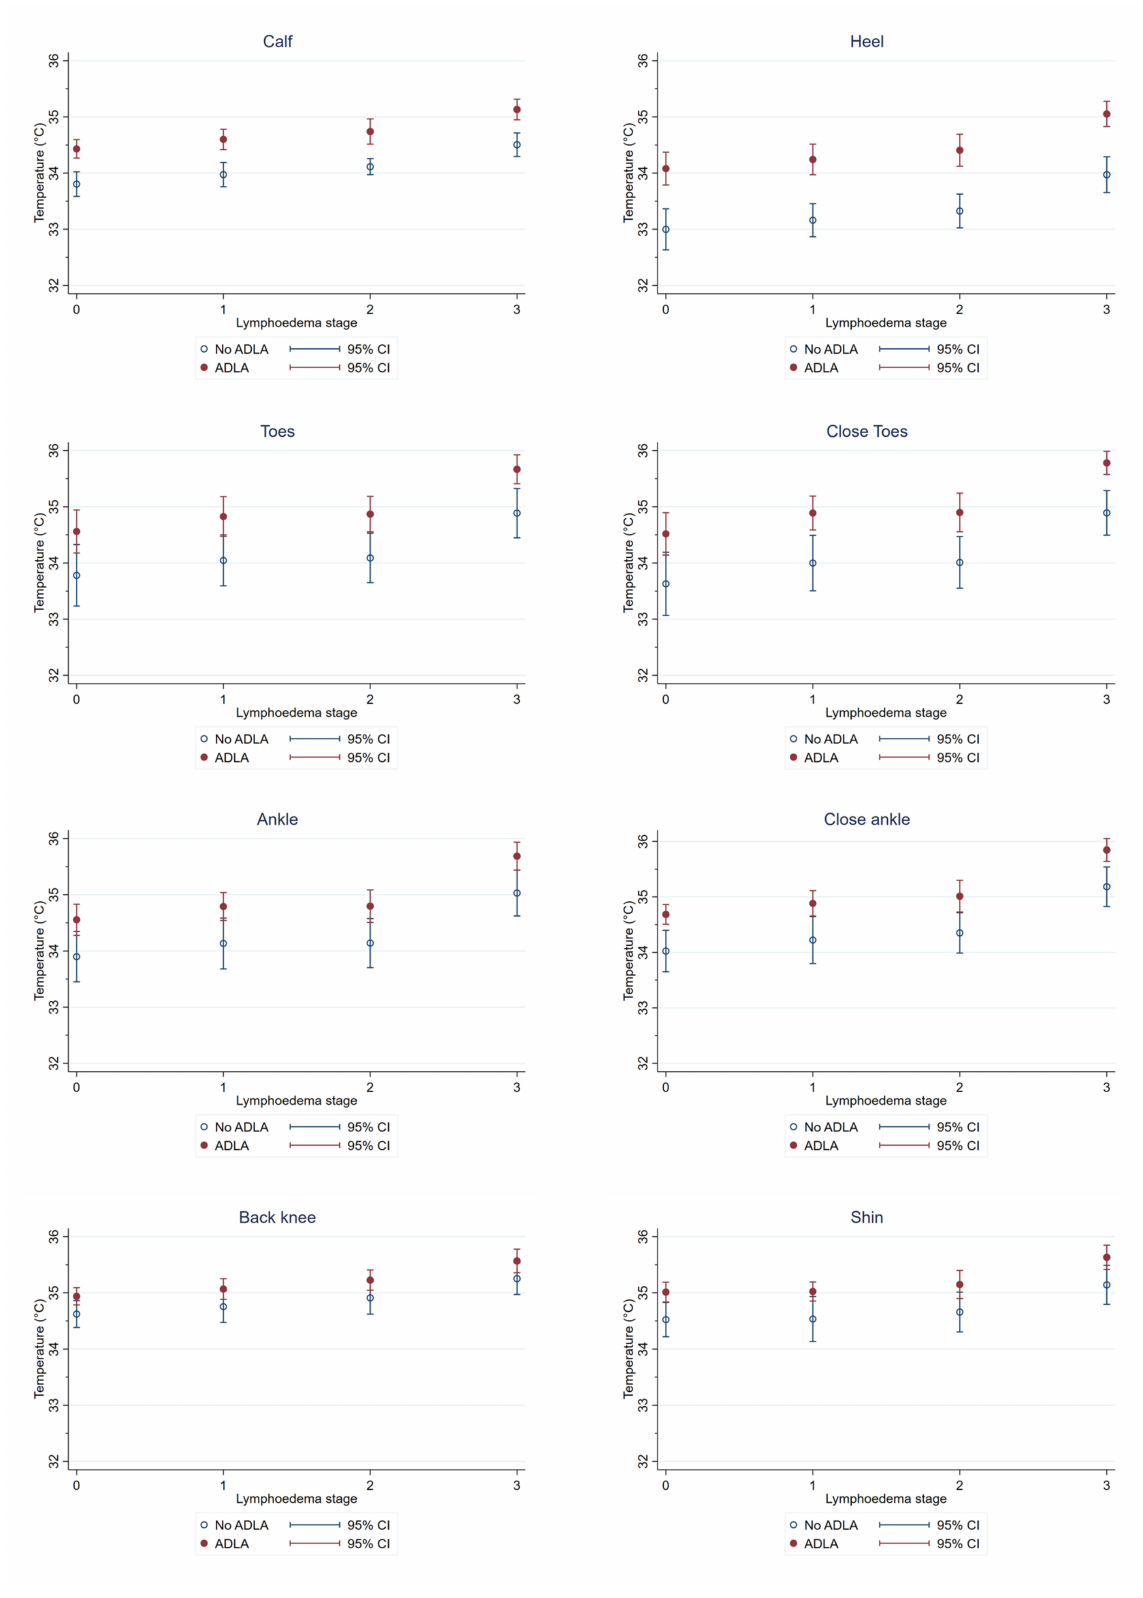
Figure 4. Comparison of temperatures at regions of interest (ROIs) by history of ADLA and lymphoedema